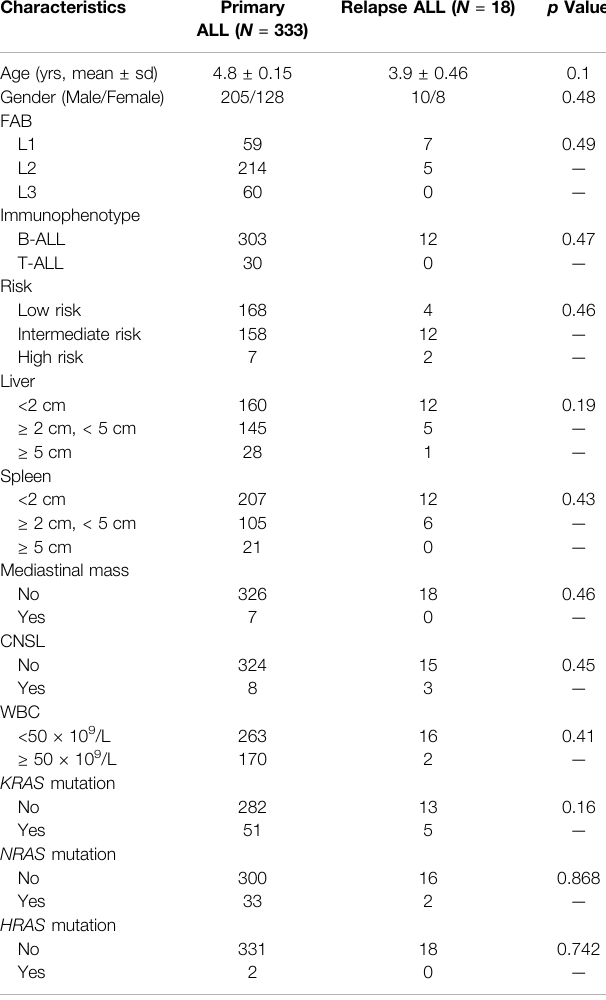
TABLE 1 | Characteristics of enrolled patients from CCCG-ALL-2015 cohort.